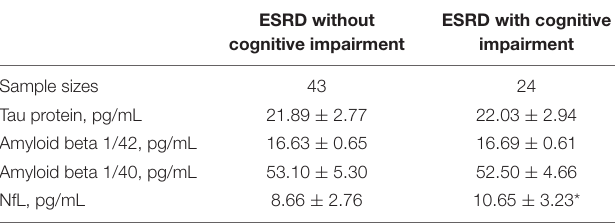
TABLE 3 | Plasma neurological biomarkers of the participants.